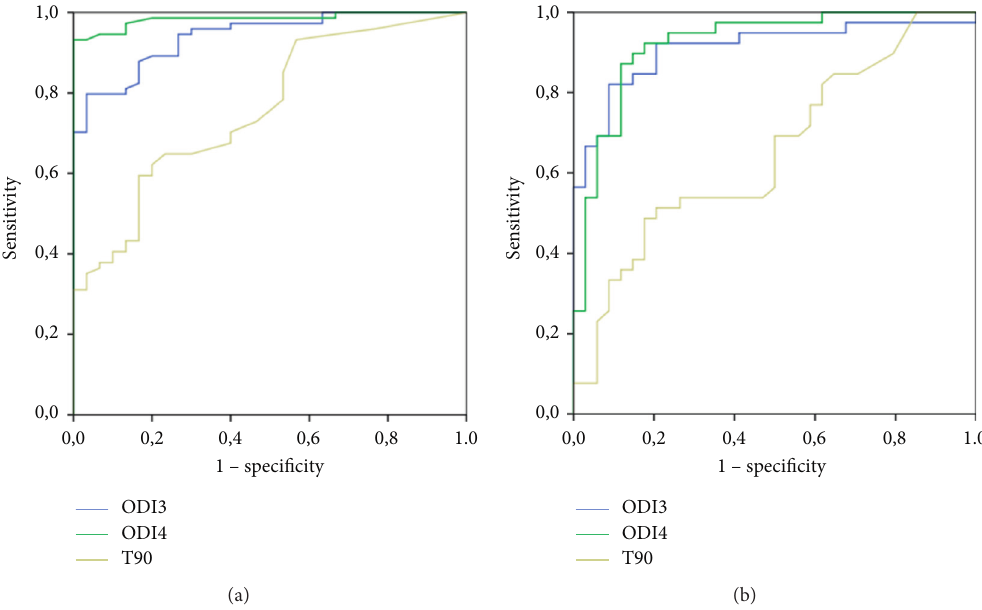
Figure 2: Receiver operating characteristic curves for oxygen desaturation index and percentage of recording with SpO thresholds. (a) AHI ≥ 10/h and (b) AHI ≥ 30/h, respectively. The discrimination degree between AHI ≥ 10/h and ODI3 (very good, AUC � 0.941) and ODI4 (excellent, AUC � 0.984) (a) and between AHI ≥ 30/h and ODI3 (very good, AUC � 0.911) and ODI4 (very good, AUC � 0.922) is shown. AHI: apnea-hypopnea index; ODIs: mean number of oxygen desaturations ≥ 3% and 4% (ODI3 and ODI4) per hour of recording; AUC: area under the